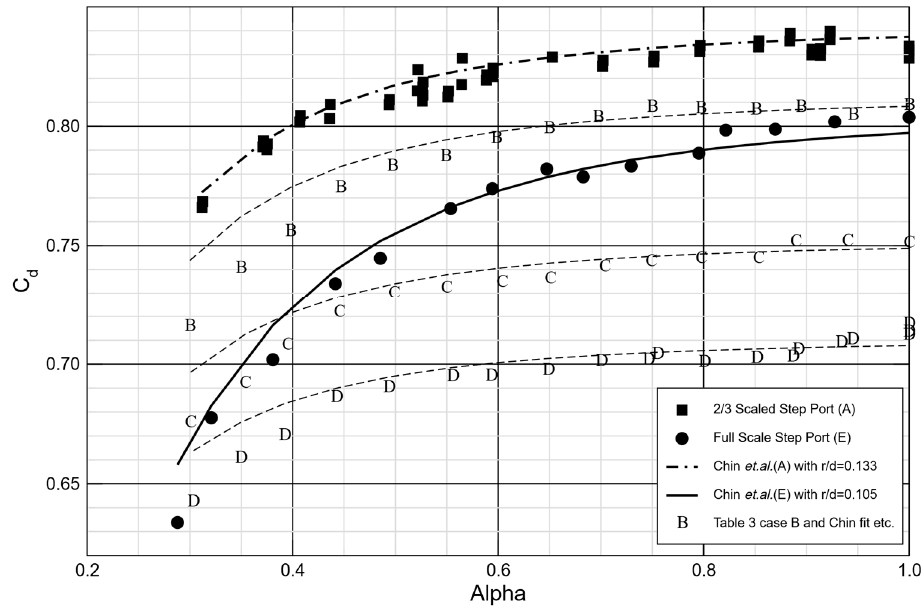
Figure 7. Stepped port C d for cases A to E. Chin et al. [11] correlation best fit by adjusting r / D .